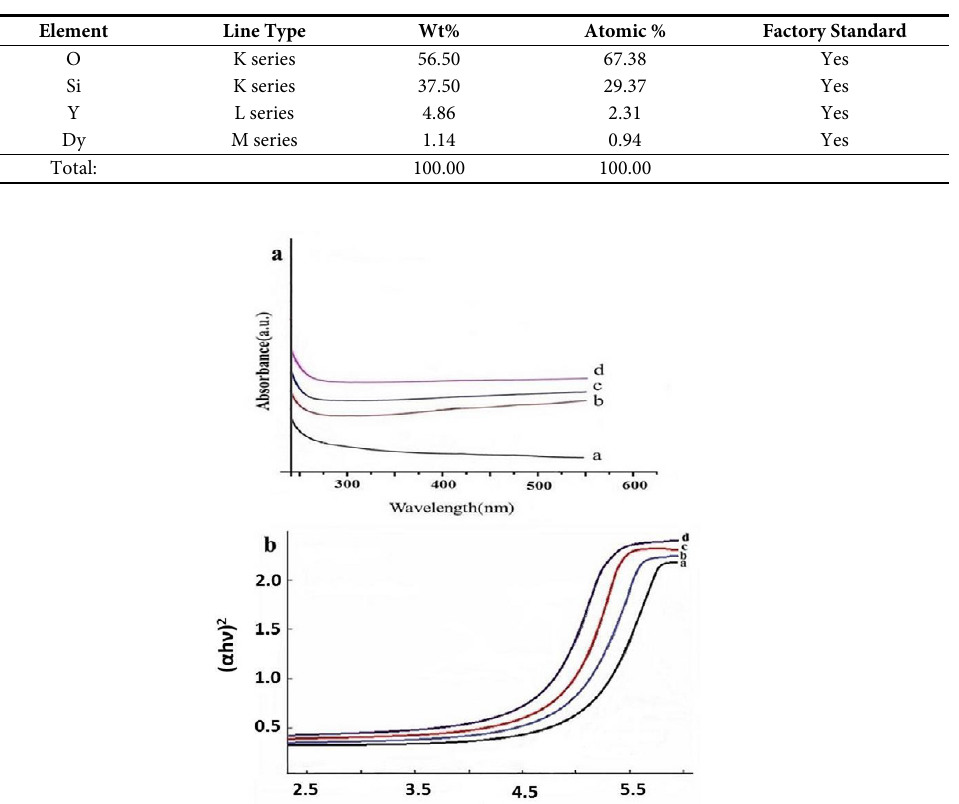
O (b), diatom coated with 6%Dy-doped 2 3 O (d) at room 2 3